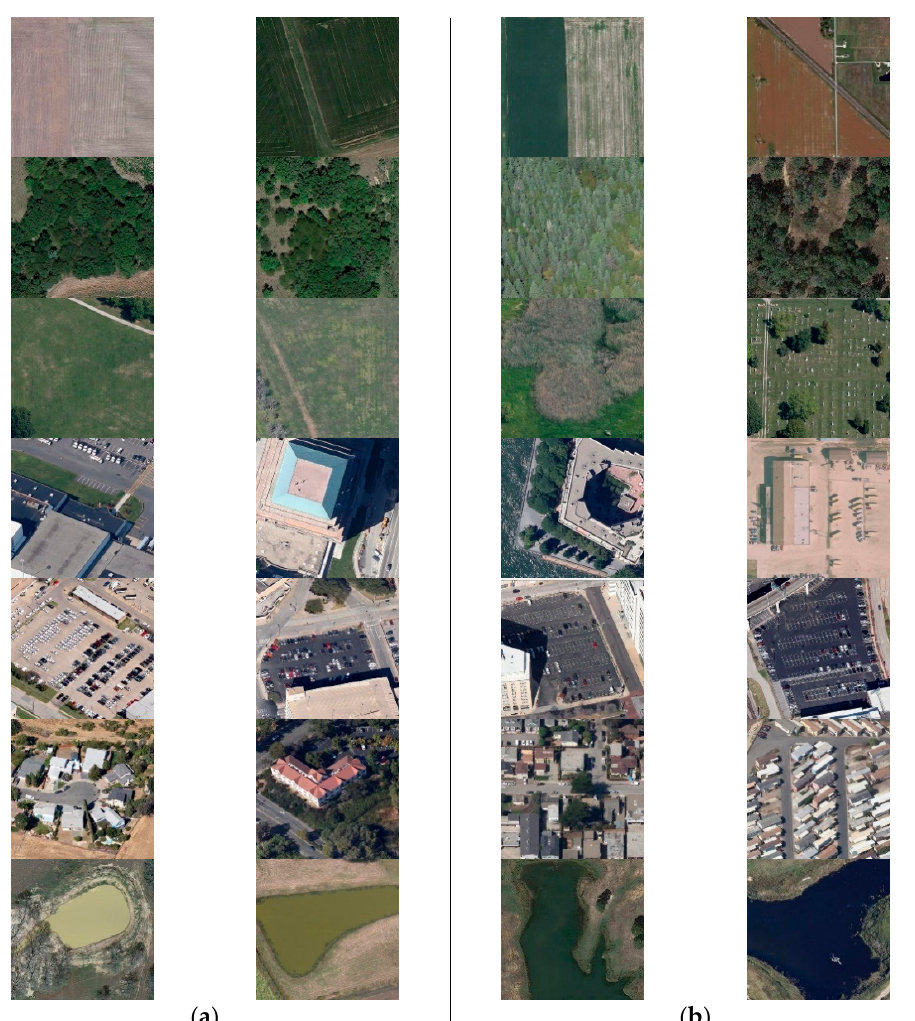
Figure 16. Some of the classification results of SGNAS and other models in the cross-domain scene data set of NWPU-RESIST45 → RSSCN7. The first, second, third, fourth, fifth, sixth, and seventh rows correspond to the scene classes of farmland, forest, grassland, industrial region, parking lot, residential region, and river and lake in the RSSCN7 dataset, respectively. ( a ) Correctly classified images for all the models. ( b ) Images classified correctly by SGNAS, but incorrectly classified by other models were used for comparison.